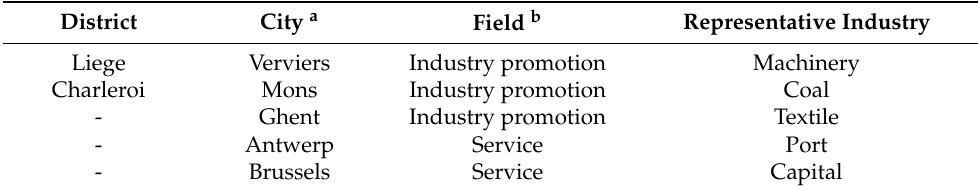
Table 1. Belgian Industrial Revolution centres.